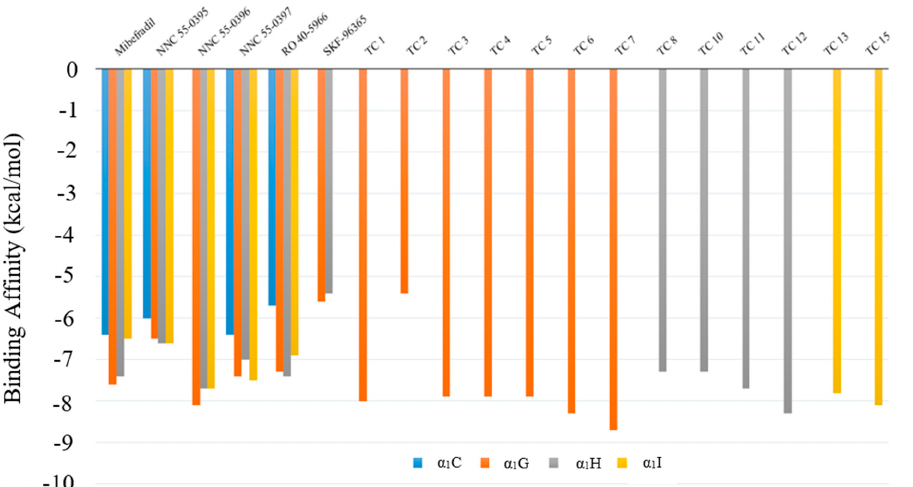
Figure 4. Predicted Gibbs free energy of select T-type Ca 2+ channel (TCC) blockers and computer- designed compounds of different receptors. Blue— α 1 C, brown— α 1 G, gray— α 1 H, and yellow— α 1